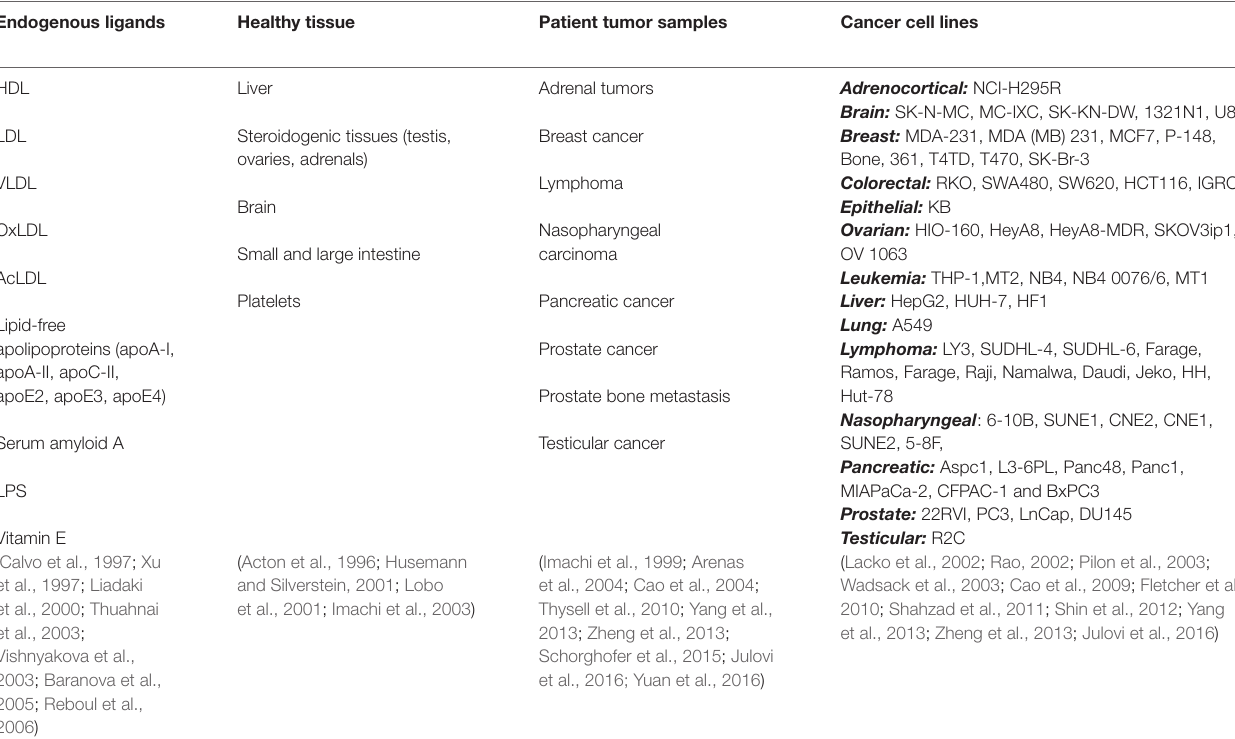
TABLE 1 | SR-BI endogenous ligands, expression in healthy tissue, upregulation in patient derived tumor samples and expression by cancer cell lines (OxLDL, AcLDL, and LPS represent oxidized LDL, acetylated LDL and lipopolysaccharides, respectively). Endogenous ligands Healthy tissue Patient tumor samples Cancer cell